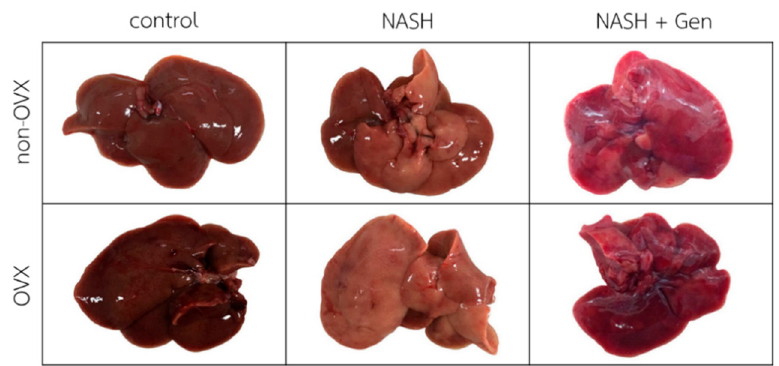
Figure 1. Gross liver appearance of rats in all experimental groups. The color of the liver is yellow-tinged and greasy in non-OVX and OVX with the high-fat, high-fructose (HFHF) diet groups. Livers in genistein groups were pink-red in color. Non-OVX: non-ovariectomized; OVX: ovariectomized; NASH: nonalcoholic steatohepatitis.